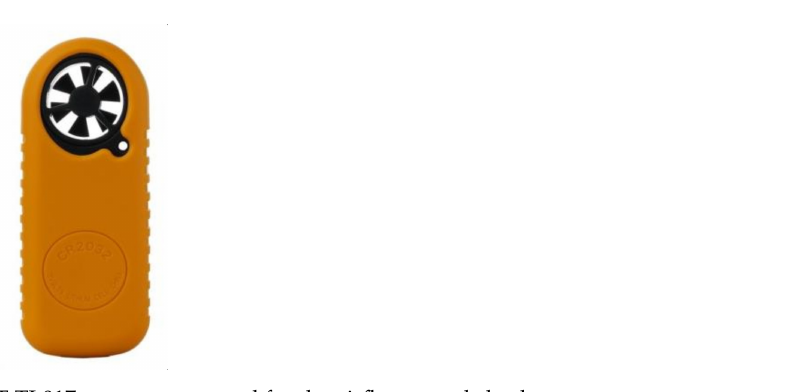
To reduce measurement noise, 1D Kalman filtering was applied to the raw data, postprocessed in the Matlab ® software environment; the results are shown in Figure 9. Preliminarily, for sensor bias estimation, digital pressure data (10-bit strings) were collected in quiet airflow (v w = 0).